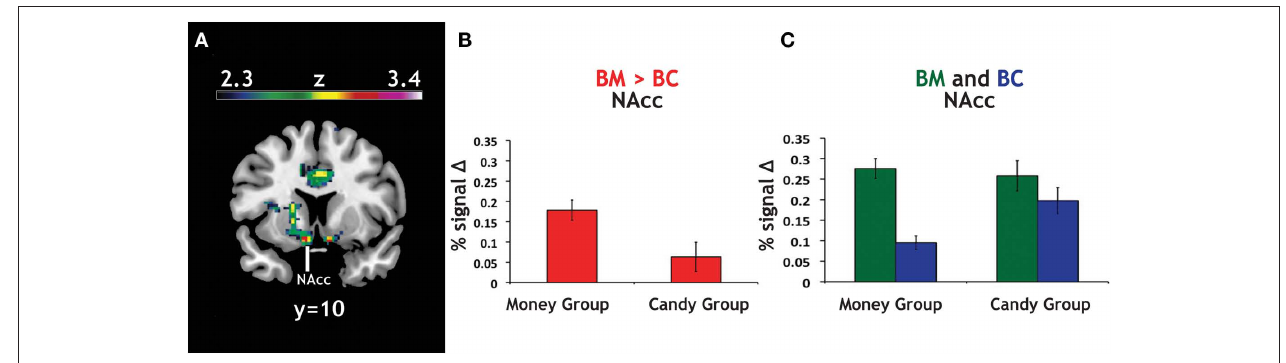
FIguRe 5 | group differences in activation for relative reward anticipation contrast. (A) We grouped our participant population into two categories based on RMI. An index value less than one (more than one) implied a relatively greater motivation for candy (money), so we divided our participant pool using this threshold. Using a whole-brain correction, we found significantly greater activation in the BM > BC contrast for our money group ( N = 46) than in our